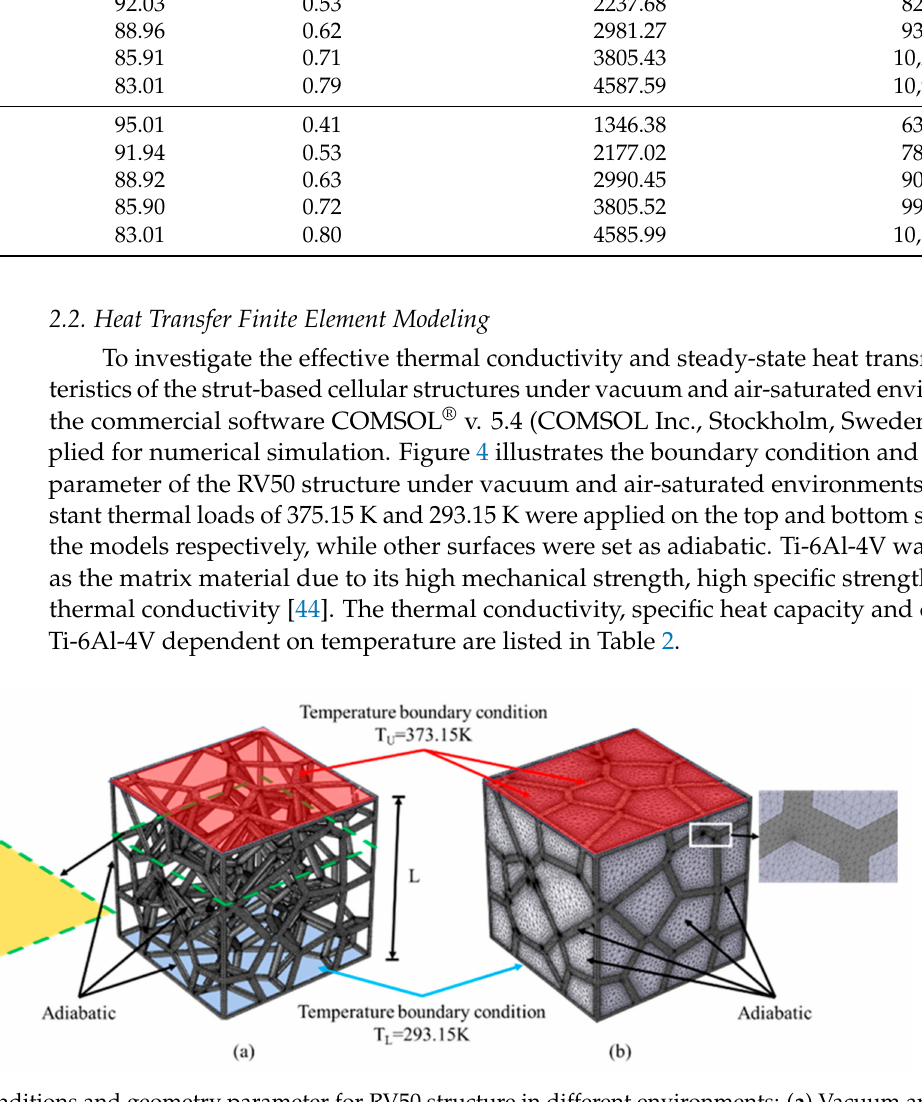
Figure 4. Boundary conditions and geometry parameter for RV50 structure in different environments: ( a ) Vacuum and ( b ) Air-saturated. Table 2. Temperature dependent physical properties of Ti-6Al-4V